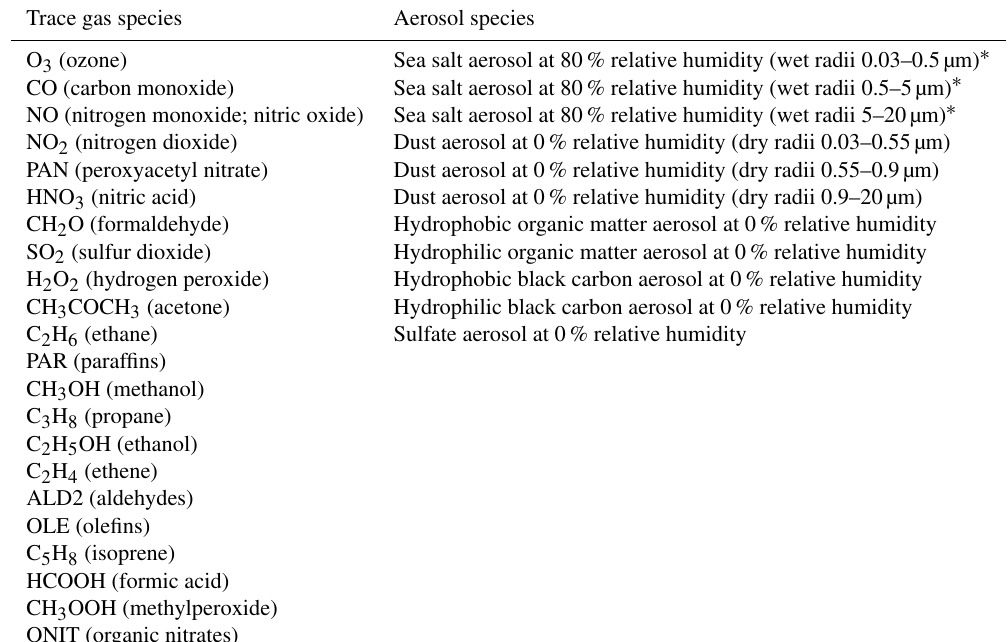
Table 2. Variables from the CAMS EAC4 reanalysis provided for the generation of initial and boundary conditions.